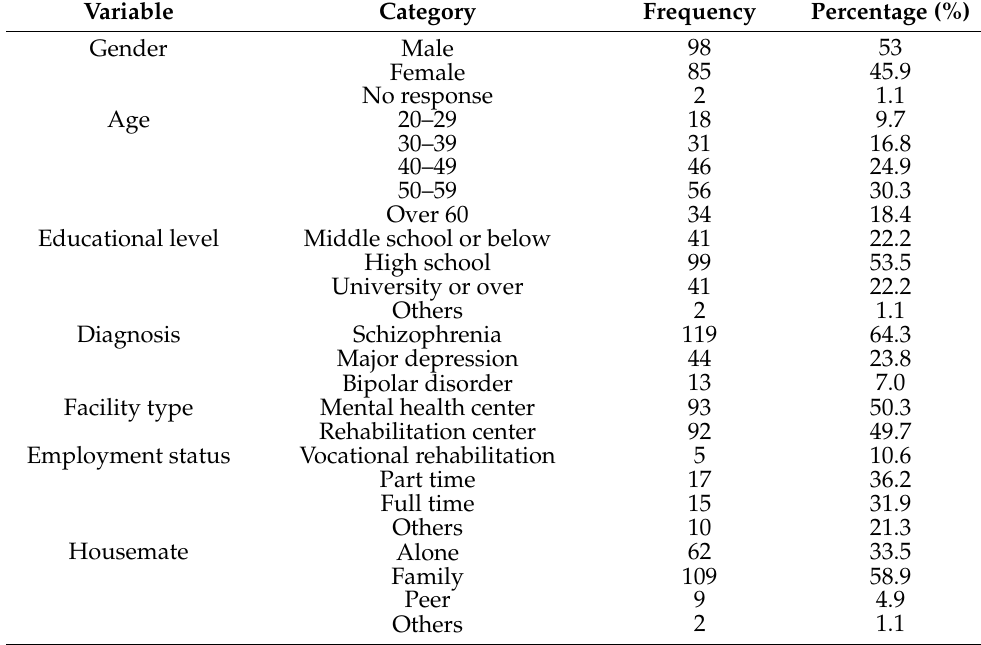
Table 1. Socio-demographic characteristics of the